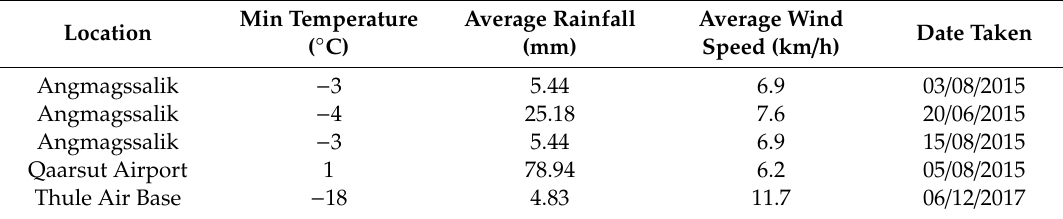
Figure 2. Google Earth image of data acquisition. Red pinpoints indicate the weather observation stations, with names shown in yellow labels. Red boxes indicate the image footprints. Green dots indicate GIS data for Greenland glacier locations. Glaciers names are in black. White compass point indicates north. 900 km indicates the scale of the image. Table 3. Average Greenland meteorological conditions for images taken. Each location is a weather observation station. Note the image taken near Savissivik is acquired in December 2017, while the images taken near Isortoq and Nuugaatsiaq are taken in August 2015. Average data represent the month of image acquisition. Temperature is monthly averaged